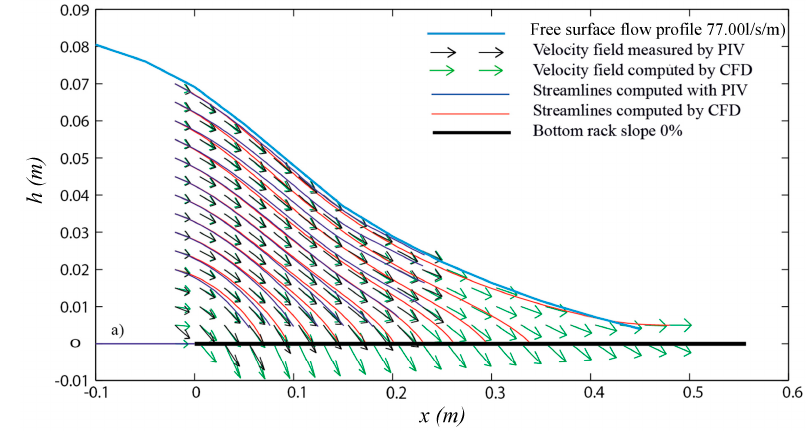
Figure 9. Velocity field and streamlines measured with PIV and simulated with CFD for rack with m = 0.28, horizontal slope, and approaching flow q 1 = 77.00 L/s/m.